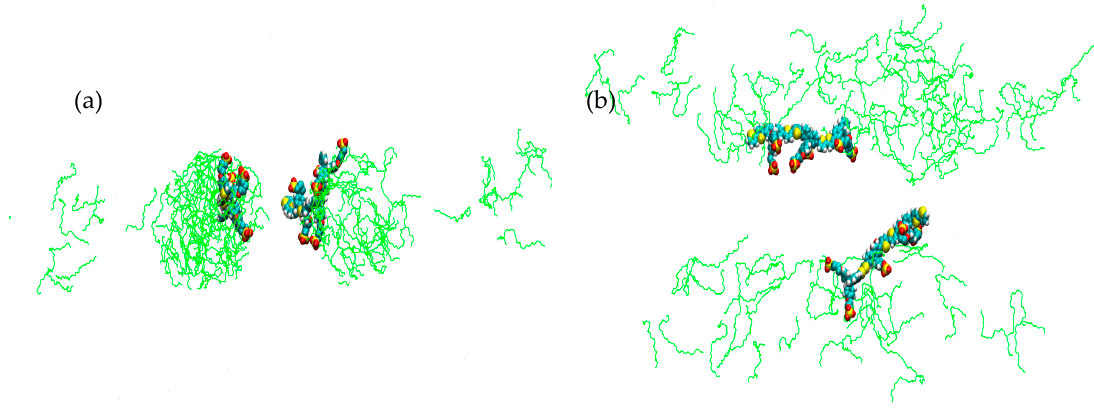
Figure 9. Simulated annealing cell representation of ( a ) front view; and ( b ) side view of 680 mM C 12 E 5 with two equivalents of PBS-PF2T at 10 °C after 35 ns (PBS-PF2T is shown in van der Waals representations and solvent is omitted for clarity).